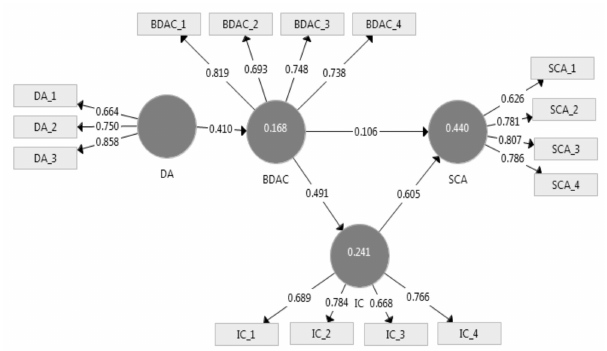
Figure A1. PLS path modeling estimation of the research model.